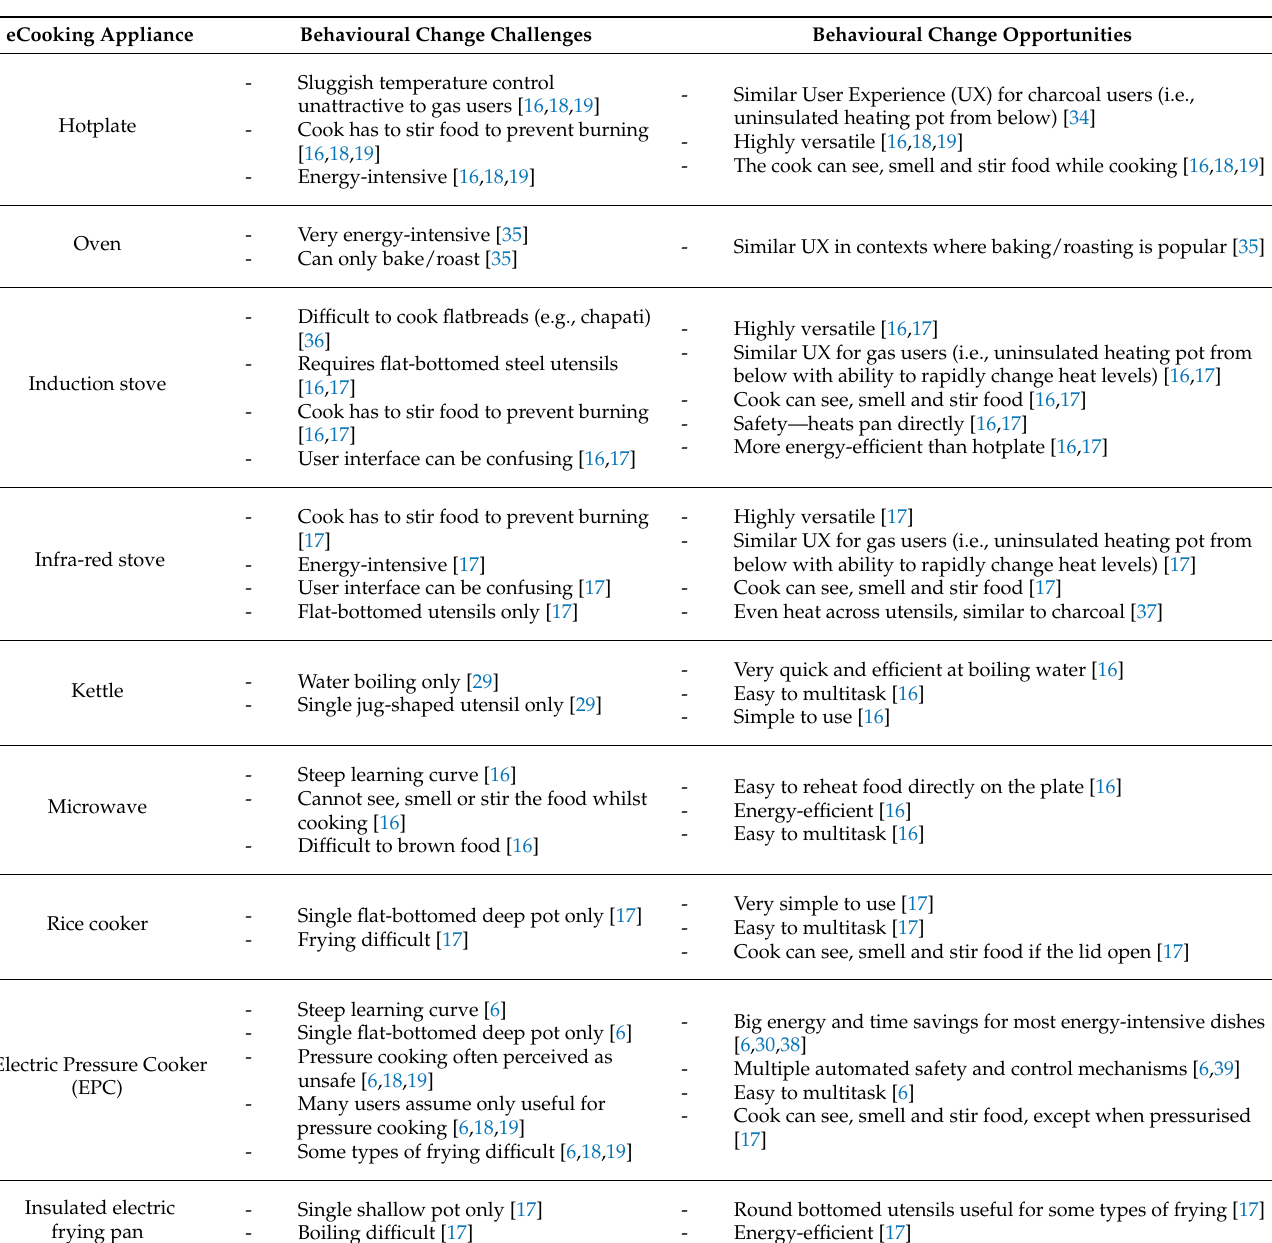
Table 1. Summary of behavioural change challenges and opportunities for popular eCooking